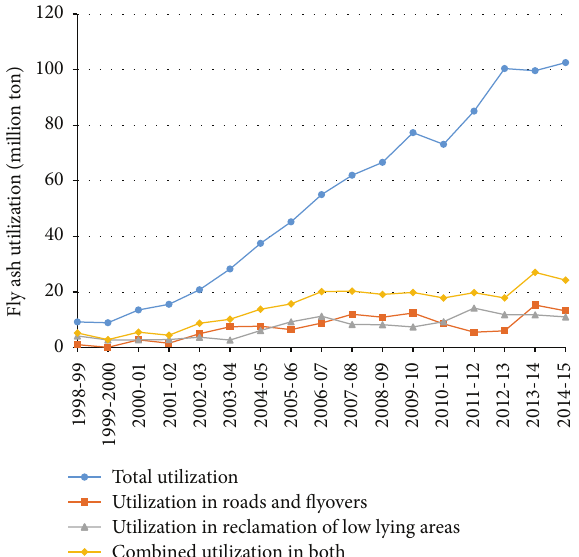
Figure 2: Utilization of FA in areas of soil engineering [1–5].